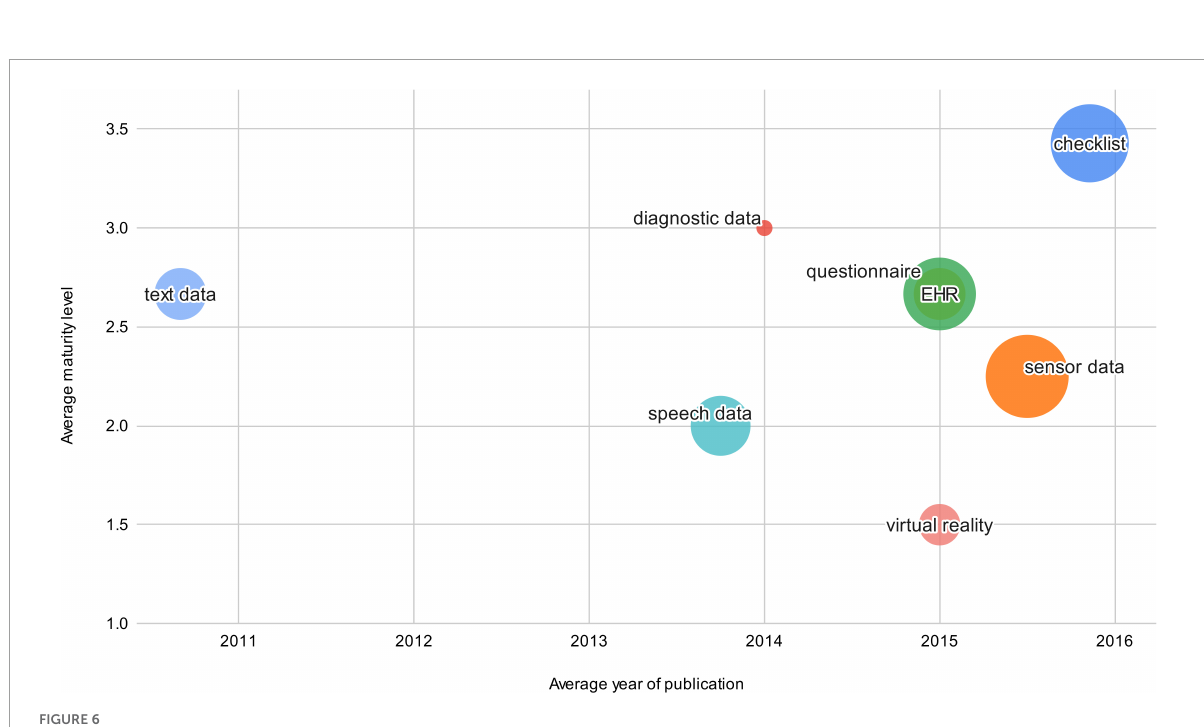
FIGURE6 Data dimension